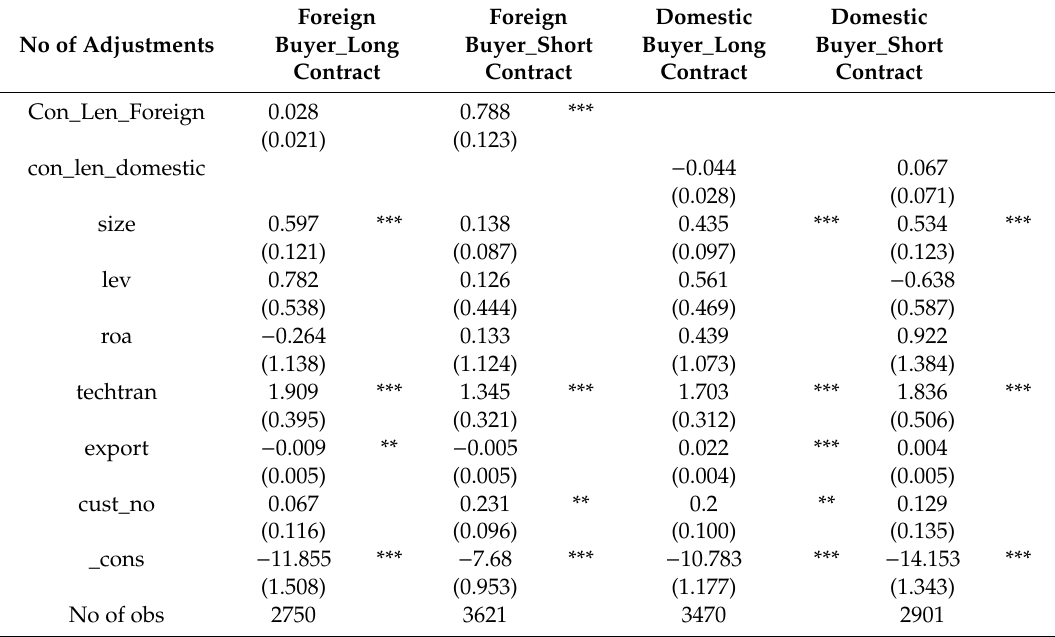
Table 6. Impact of contract length on the number of successful